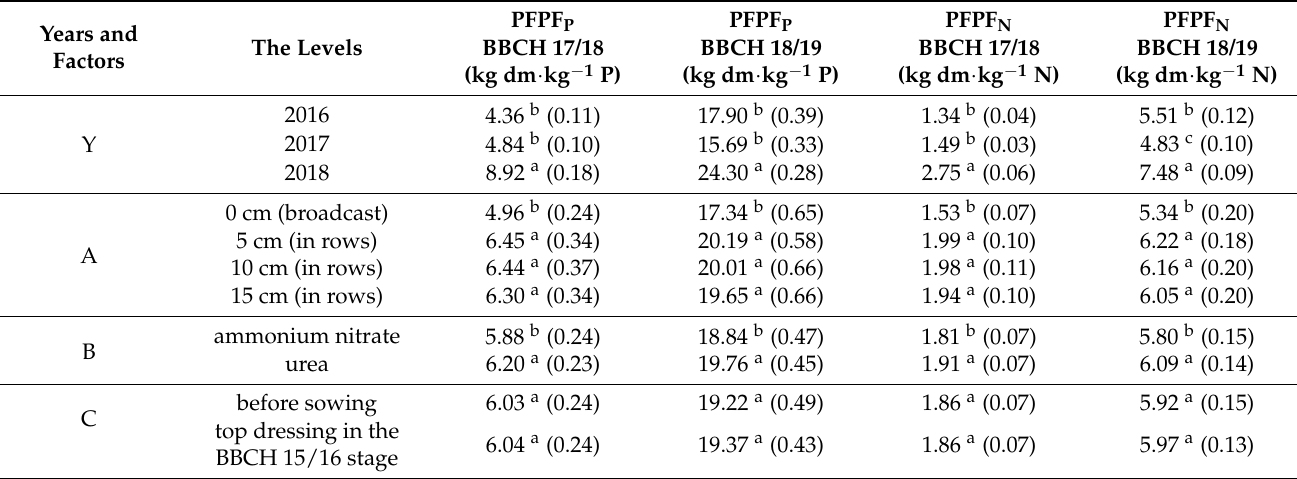
Table 8. Mean values of the traits for the years and (Y) NP fertilizer sowing depth (A), type of supplementary nitrogen fertilizer (B), date of supplementary nitrogen fertilization (C). Years and